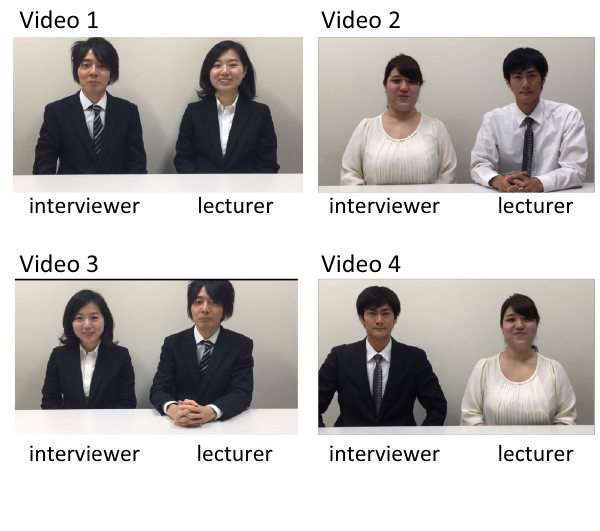
Table 2 Subcategories of the Japanese concepts of admiration and